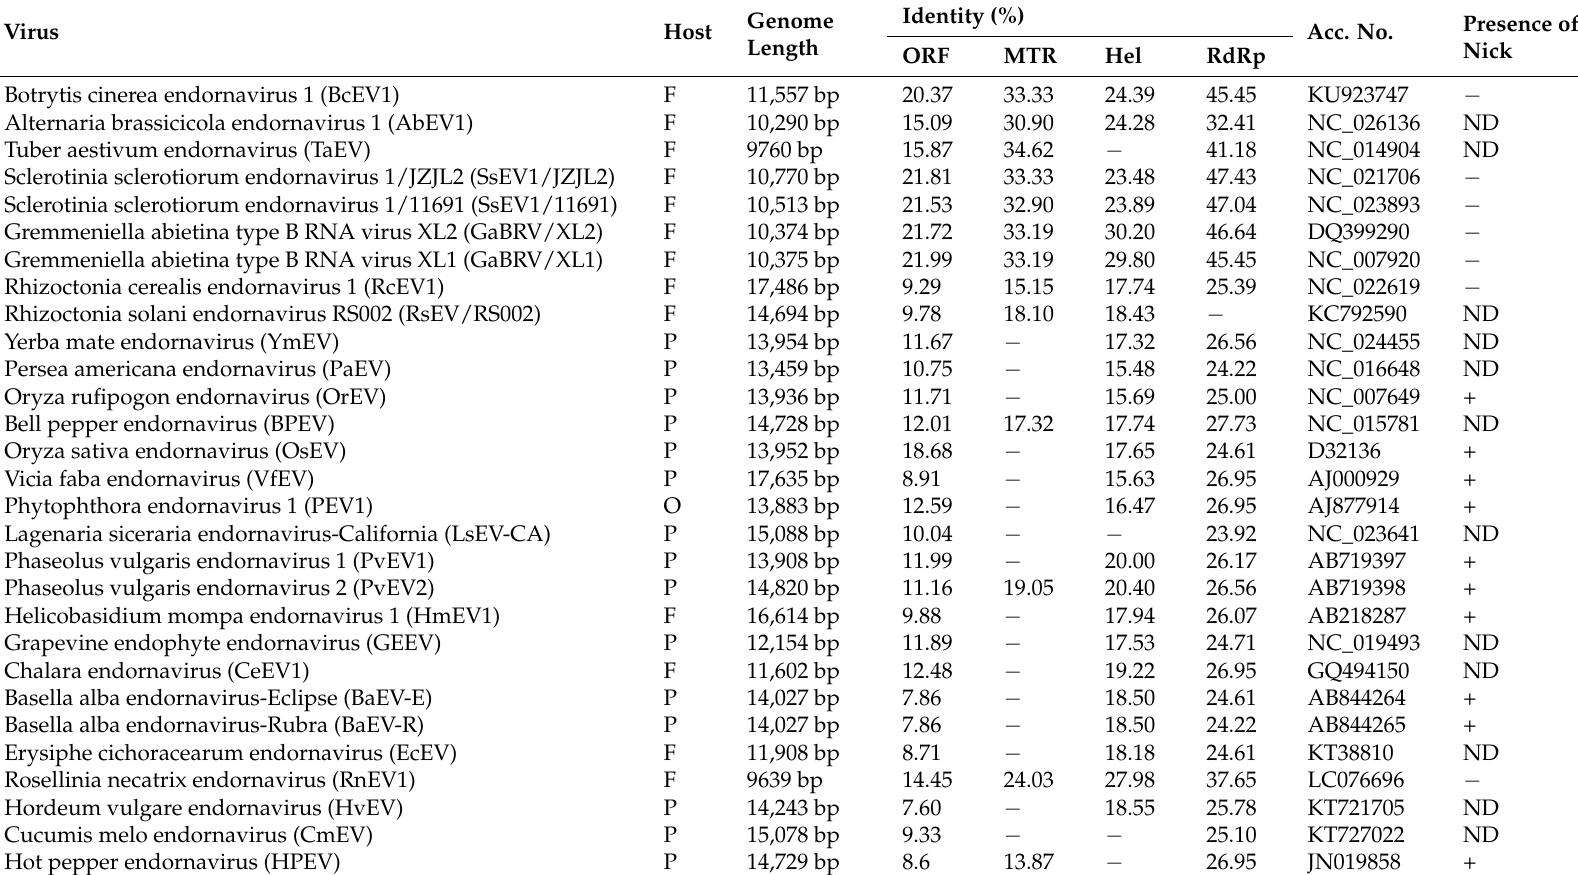
Table 2. Percent identity of amino acid sequences between SmEV1 and other endornaviruses determined by multiple alignments of the full-length polyprotein sequence and the conserved domains coding for methyltransferase (MTR), helicase 1 (Hel 1), RNA-dependent RNA polymerase (RdRp). Virus Host